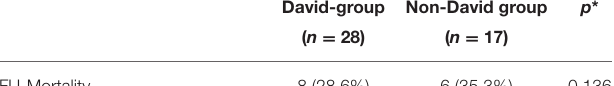
FIGURE 2 | Kaplan-Meier survival David vs. non-David